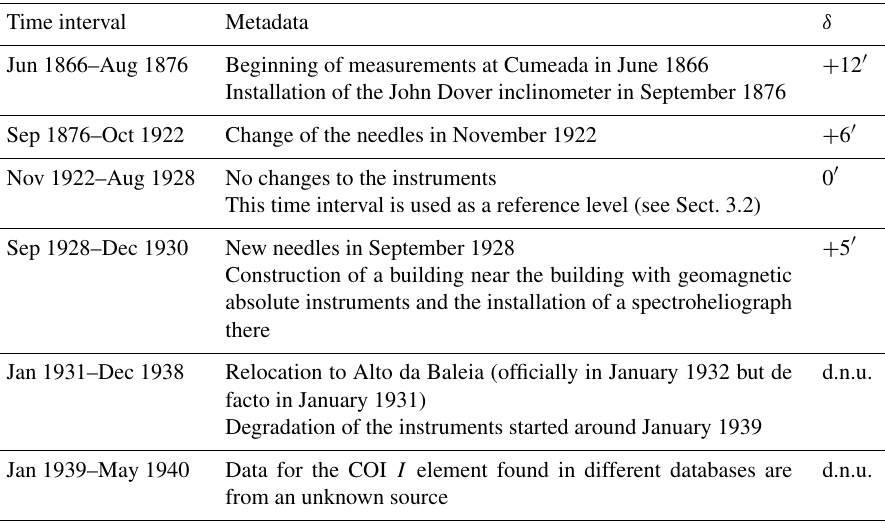
Table 2. Metadata for the I data set at the Cumeada and the Alto da Baleia sites: dates of the instrument replacements, relocations, changes to the measurement and calculation procedures, etc. Estimated corrections ( δ ) for the COI series for different time intervals are in the third column. “d.n.u.” – it is not recommended to use the data for this time interval.